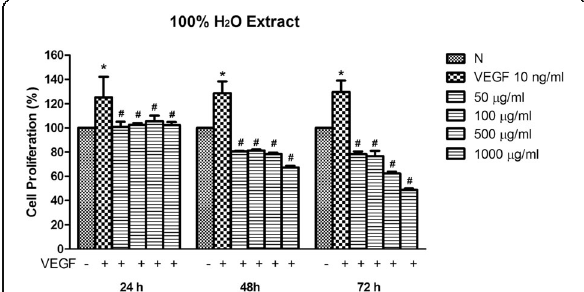
Fig. 2 Effect of C. nutans water extract on VEGF-induced HUVECs proliferation. HUVECs were co-treated with 50 – 1000 μ g/ml C. nutans water extract and 10 ng/ml VEGF for 24, 48 and 72 h. The values presented are the mean ± SEM of three independent experiments and compared against normal control (N). * p < 0.05